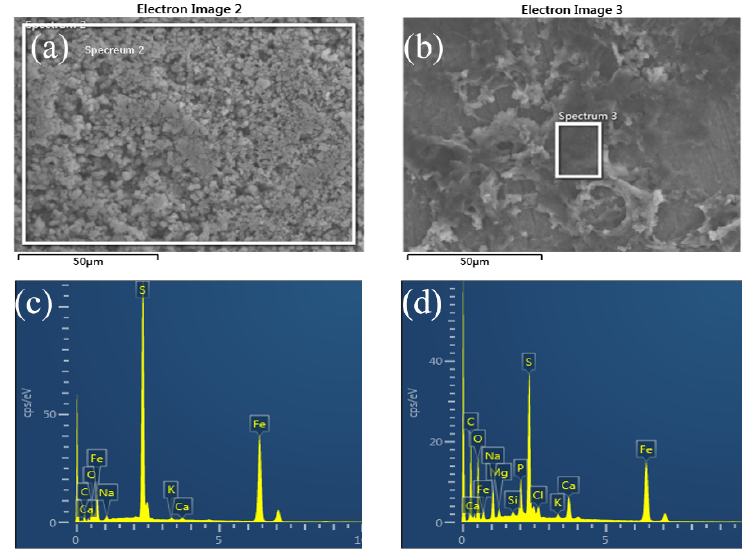
Figure 2. The morphologies and corresponding EDS spectra of ( a , c ) the cauliflower-like and ( b , d ) the network-like products of the Q235 steel after 7-day incubation in an SRB-Z-inoculated medium.